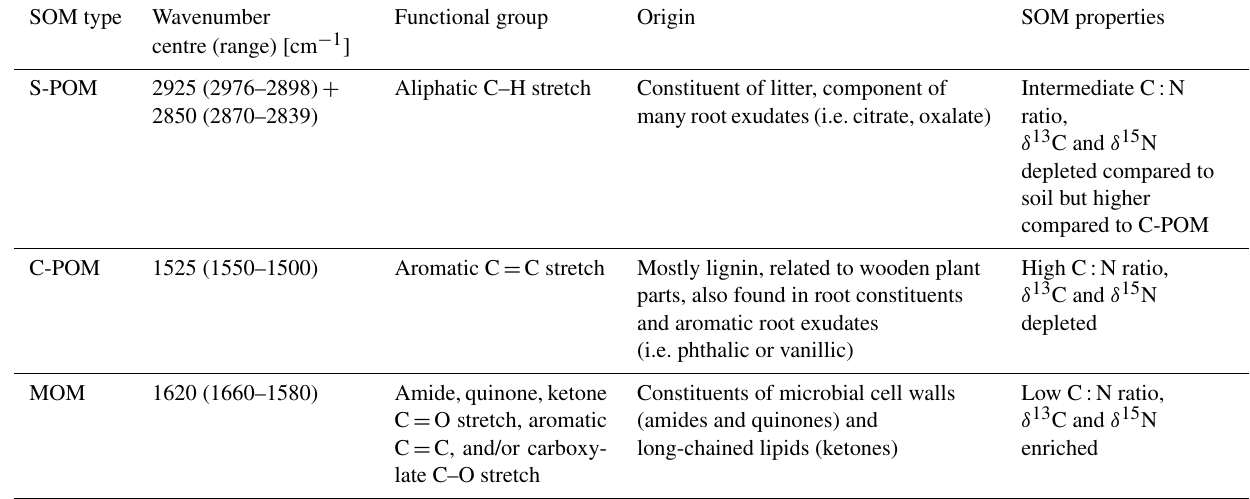
Table 1. Overview of wavenumber ranges used to calculate absorbance peak areas from DRIFTS, the respective functional groups related to specific biochemical properties of SOM compounds and compiled information on the origin (Demyan et al., 2012; Parikh et al., 2014; Hall et al., 2018), and the respective SOM properties (C:N ratio, δ 13 C, and δ 15 N values) of each functional group (Benner et al., 1987; Austin and Vitousek, 1998; Dijkstra et al., 2006; Xu et al., 2010; Vranova et al., 2013). SOM